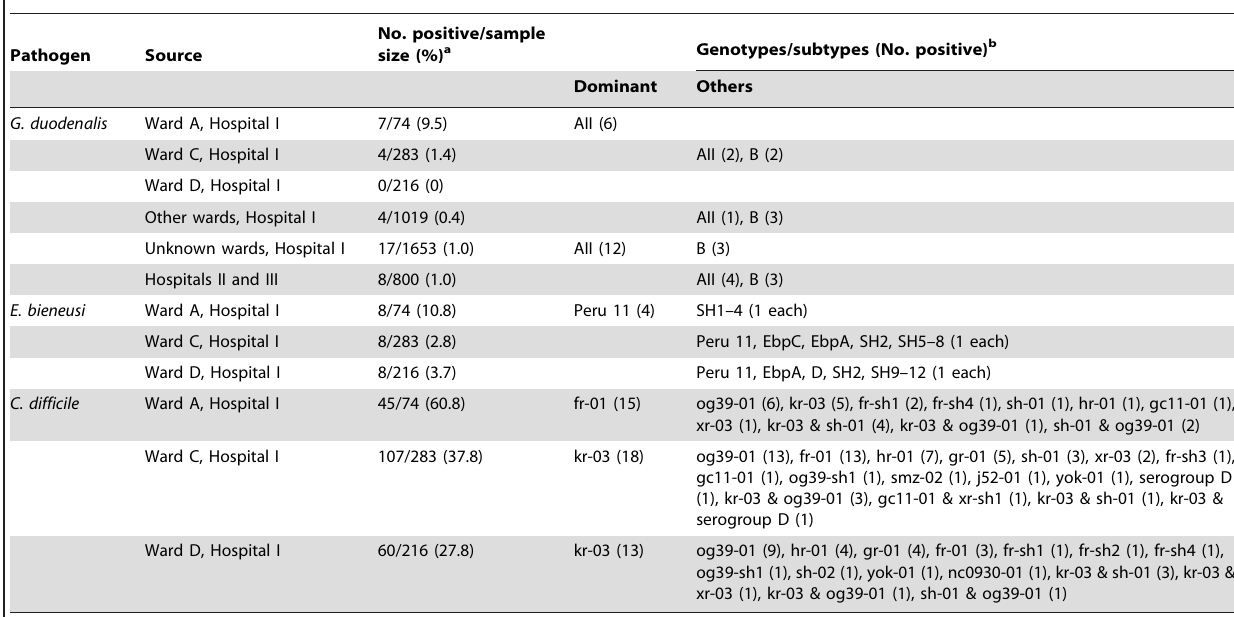
Table 3. Distribution of Giardia duodenalis , Enterocytozoon bieneusi , and Clostridium difficile genotypes or subtypes.